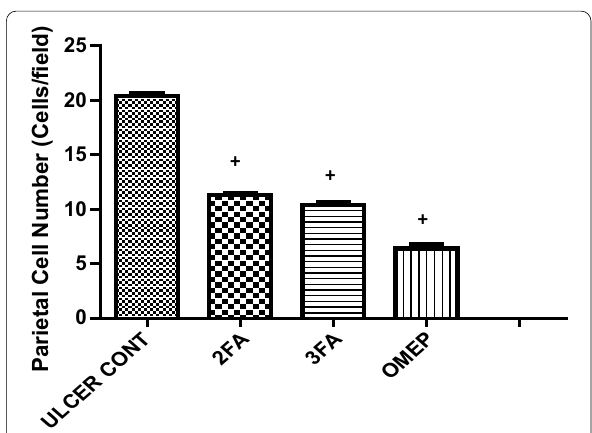
Fig. 6 Parietal cell numbers in the stomach mucosa of rats treated with varying doses of folic acid and Omeprazole after pyloric ligation ulcer. (** p < 0.001 ulcer control cf. control; + p < 0.05 cf. ulcer control). ULCER CONT Pylorus ligation Ulcer control, 2FA = acid, 3FA